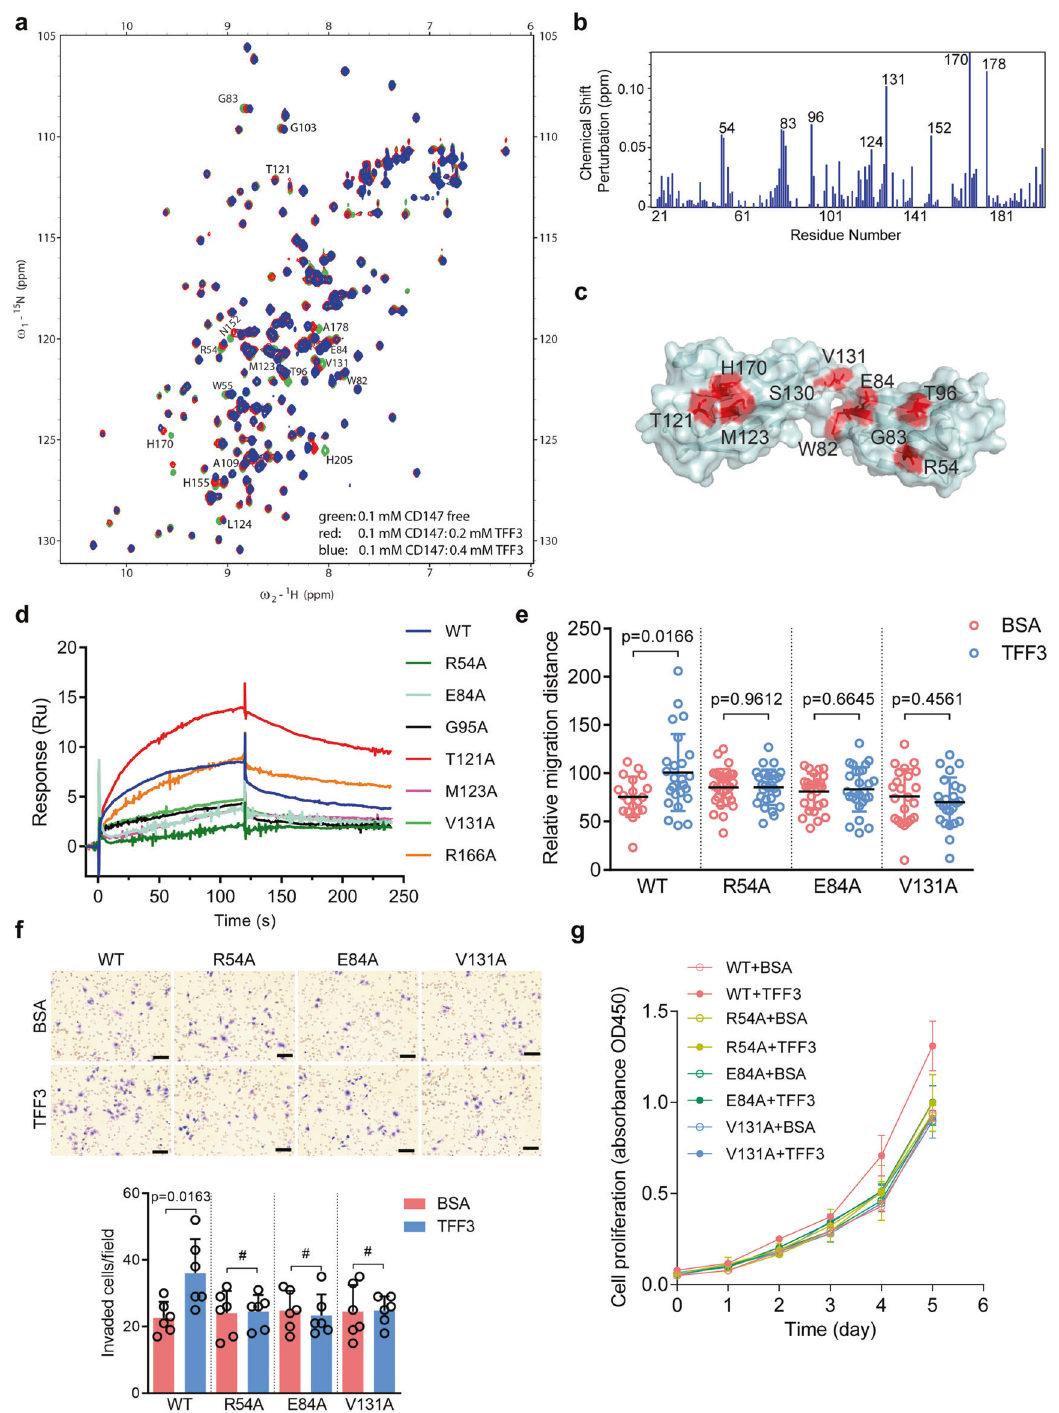
Fig. 2 De fi ning the binding site of TFF3 on CD147 and the key residues. a 15 N- 1 H-HSQC spectra for 0.1 mM CD147 ECD were generated in the presence of 0.2 mM (red) or 0.4 mM (blue) TFF3, or the absence of TFF3 (green); the spectra were then superimposed. Residues that show CSPs due to TFF3 binding are labeled. b Plot of chemical shift perturbations between CD147 ECD /TFF3 (ratio 1:4) and free CD147 ECD . Residues with signi fi cant CSPs [ Δδ (N – H) > 0.048 ppm] were labeled. c TFF3-induced CSPs mapped onto the 3D structure of human CD147 ECD (PDB ID: 3B5H, residues 22 – 203). The colors in the space- fi lling model correspond to the amplitude of the observed CSPs [red: Δ δ (N – H) > 0.035 ppm]. d Biacore diagram of human TFF3 protein bound to CD147 ECD mutants. e Quanti fi cation of the migration ability of HCT-8 CD147KO cells transfected with wild-type (WT), R54A, E84A, or V131A CD147 in the presence of 0.152 μ M of TFF3 or BSA treatment. f Representative images of HCT-8 CD147KO cells invading through matrigel-coated transwell inserts towards serum for 24 h. Cells transfected with WT, R54A, E84A, or V131A CD147 were treated with 0.152 μ M of TFF3 or BSA. Scale bar, 50 μ m. The graph shows the average number of invaded cells per fi eld. The p -values in e – f were determined by using a two-tailed Student ’ s t -test ( # p > 0.05). g Proliferation curve of HCT-8 CD147KO cells determined by CCK-8 assays. Cells transfected with WT, R54A, E84A, or V131A CD147 were treated with 0.152 μ M of TFF3 or